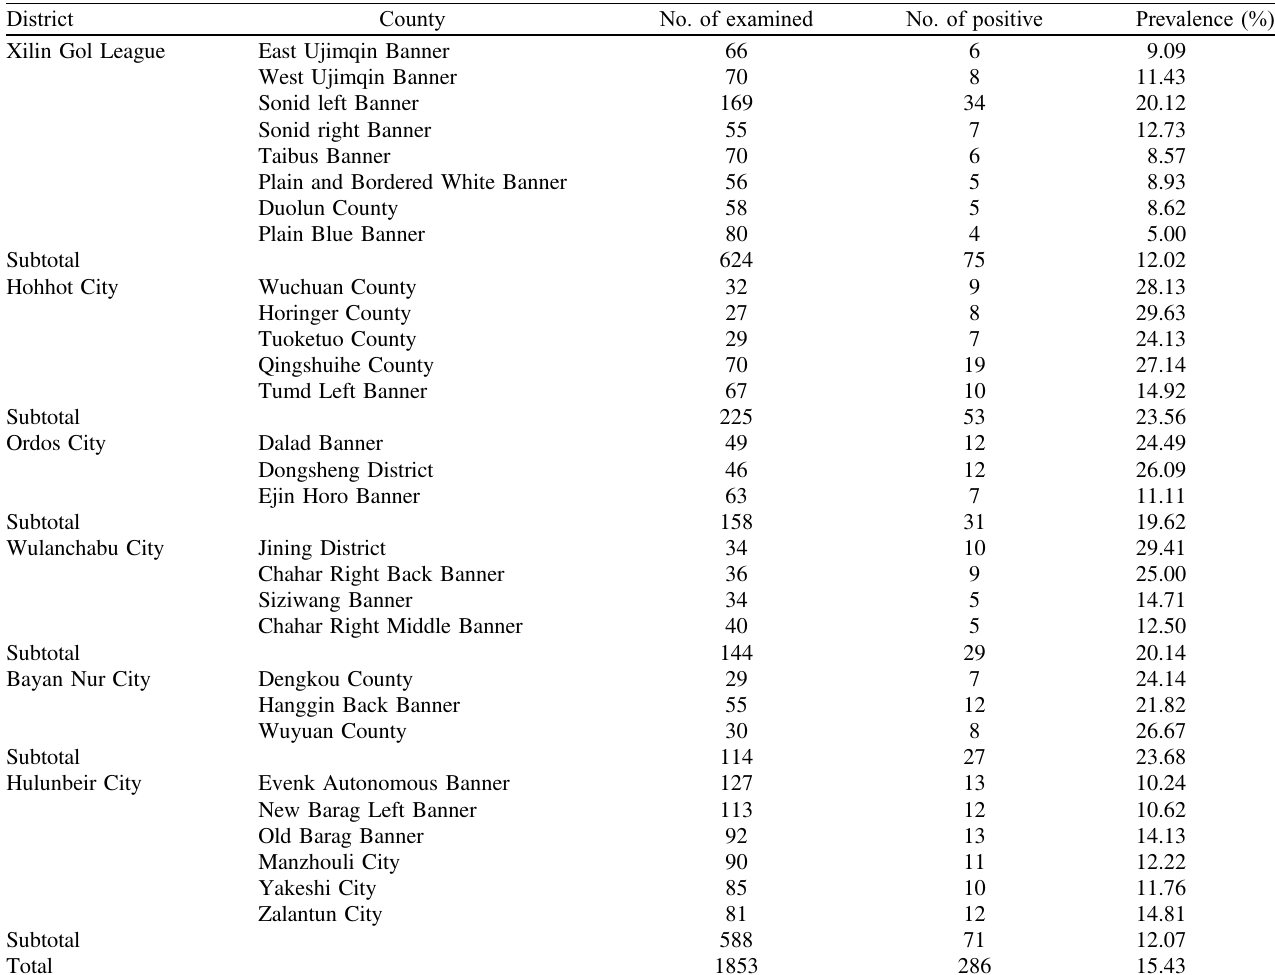
Table 1. Prevalence of T. gondii infection in different districts by ELISA.